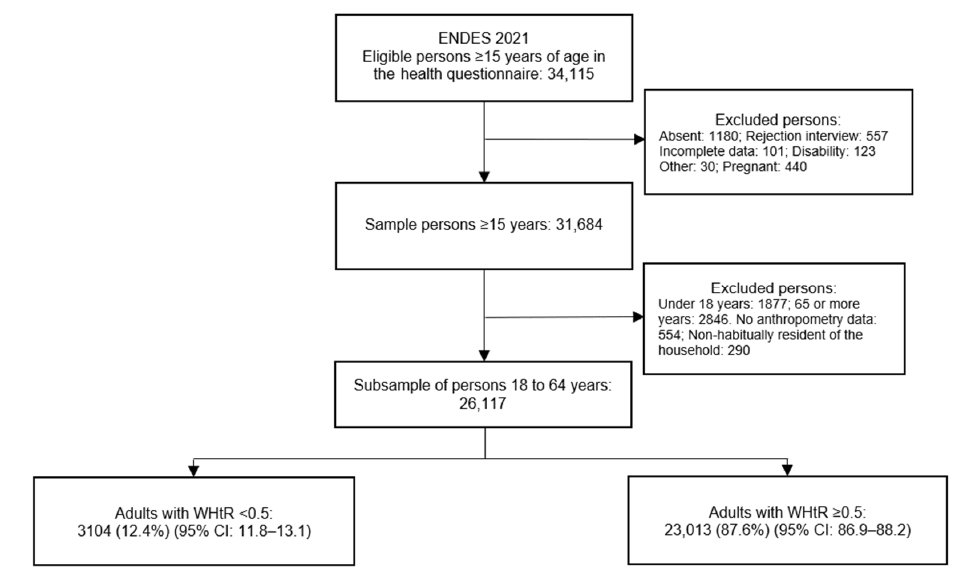
Figure 1. Flow chart of the selection of adults included in the study.